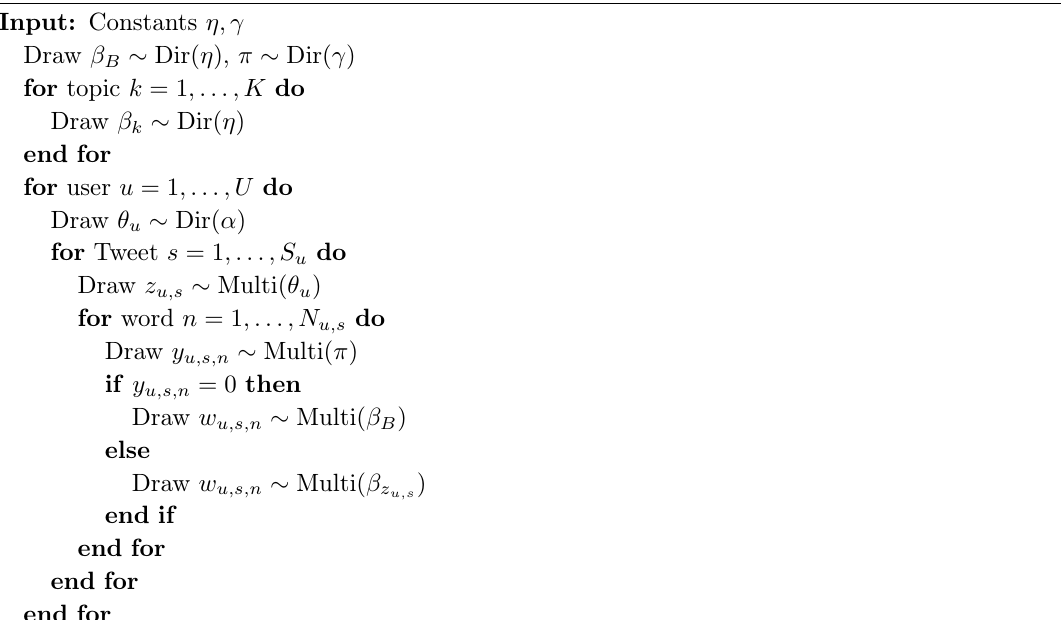
Algorithm 1 Generating process for